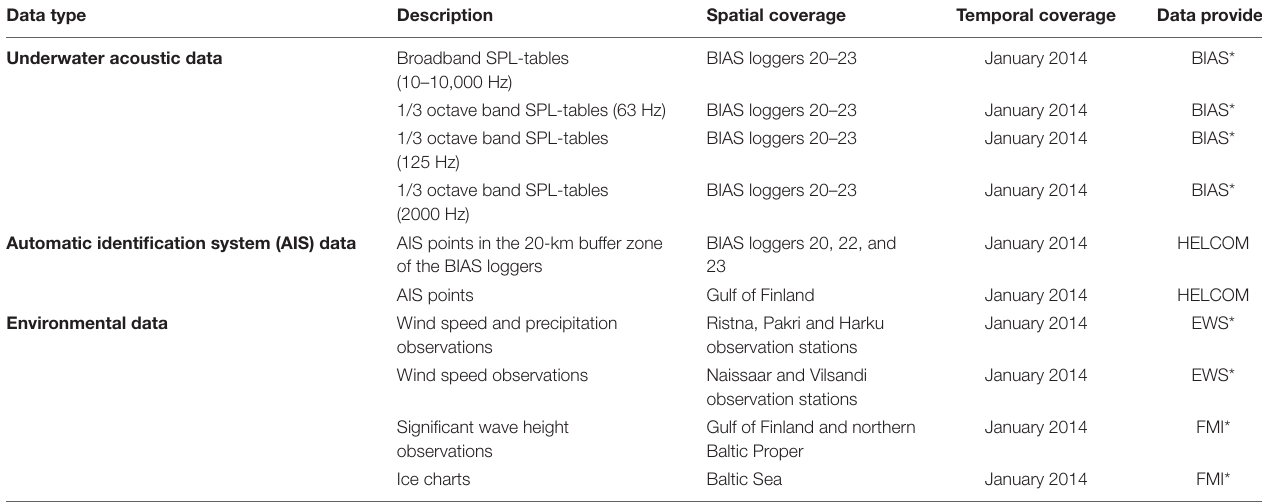
TABLE 2 | Summary of the collected data and their origins in this